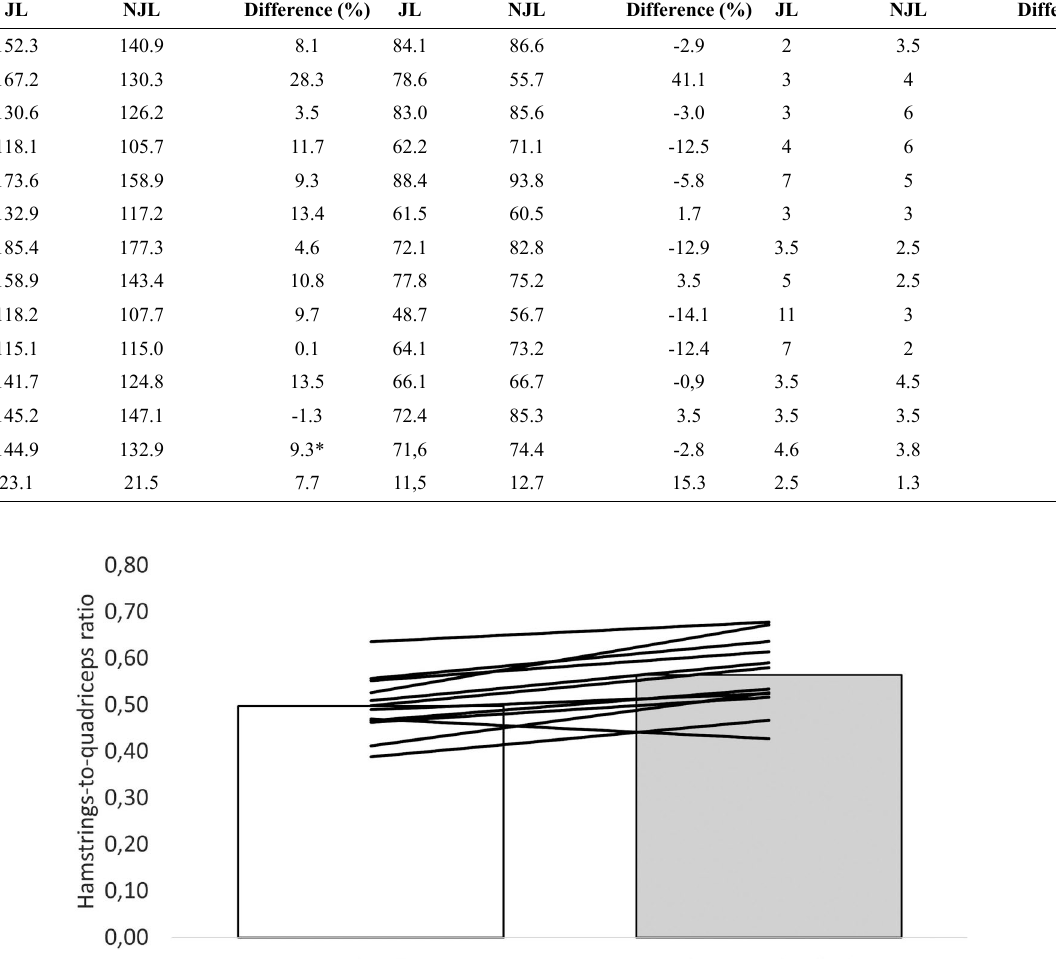
Table 1 - Individual and mean values for knee extension and knee flexion isokinetic peak torque (IPT) for the jumping limb (JL) and non-jumping limb (NJL). *p < 0.01 comparing the jumping limb and non-jumping limb values. Knee extension IPT